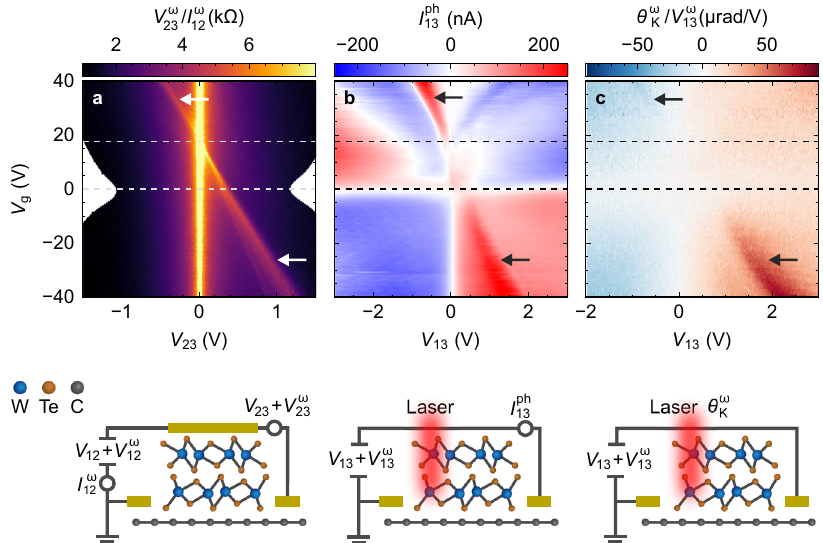
= I ω as a function of gate voltage V g and DC drain-source voltage V 23 . A 23 12 vs. V g . In each case, the corresponding experimental con fi guration is displayed 13